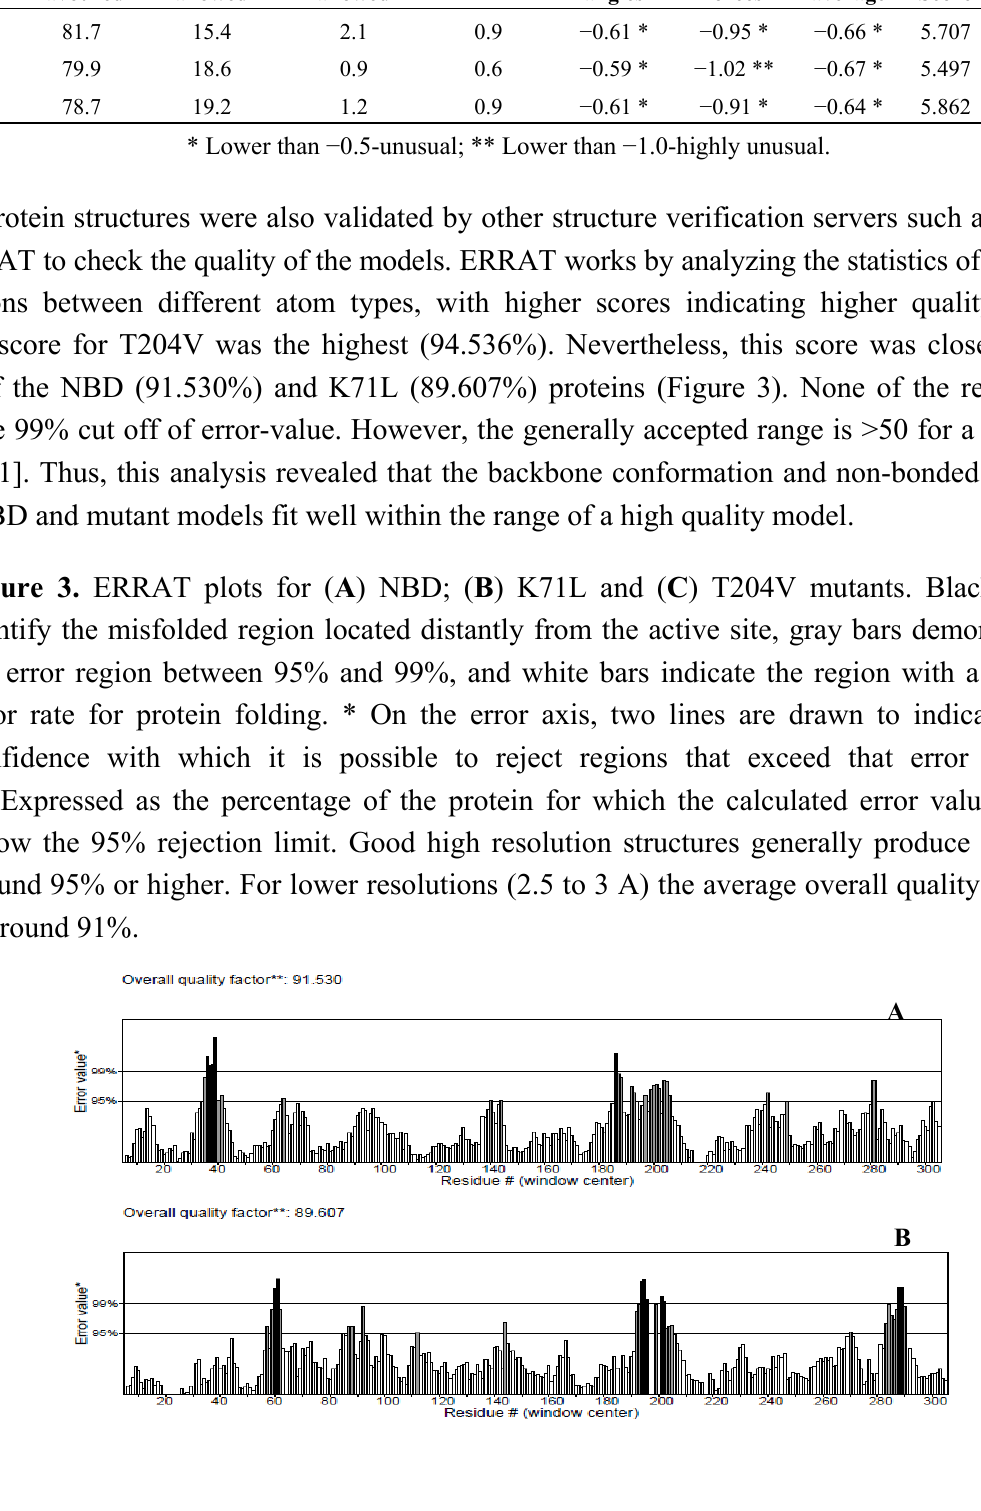
Table 3. Validation of NBD, K71L and T204V mutants using PROCHECK and ProQ.